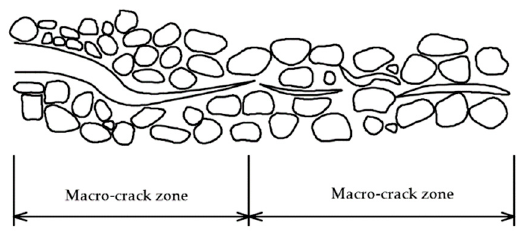
Figure 13. Frost-heave propagation of cracks. Table 3. Crack initiation and unstable propagation strain.